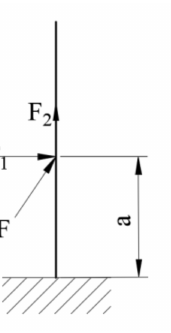
Figure 15. Branch unsupported cutting force diagram.